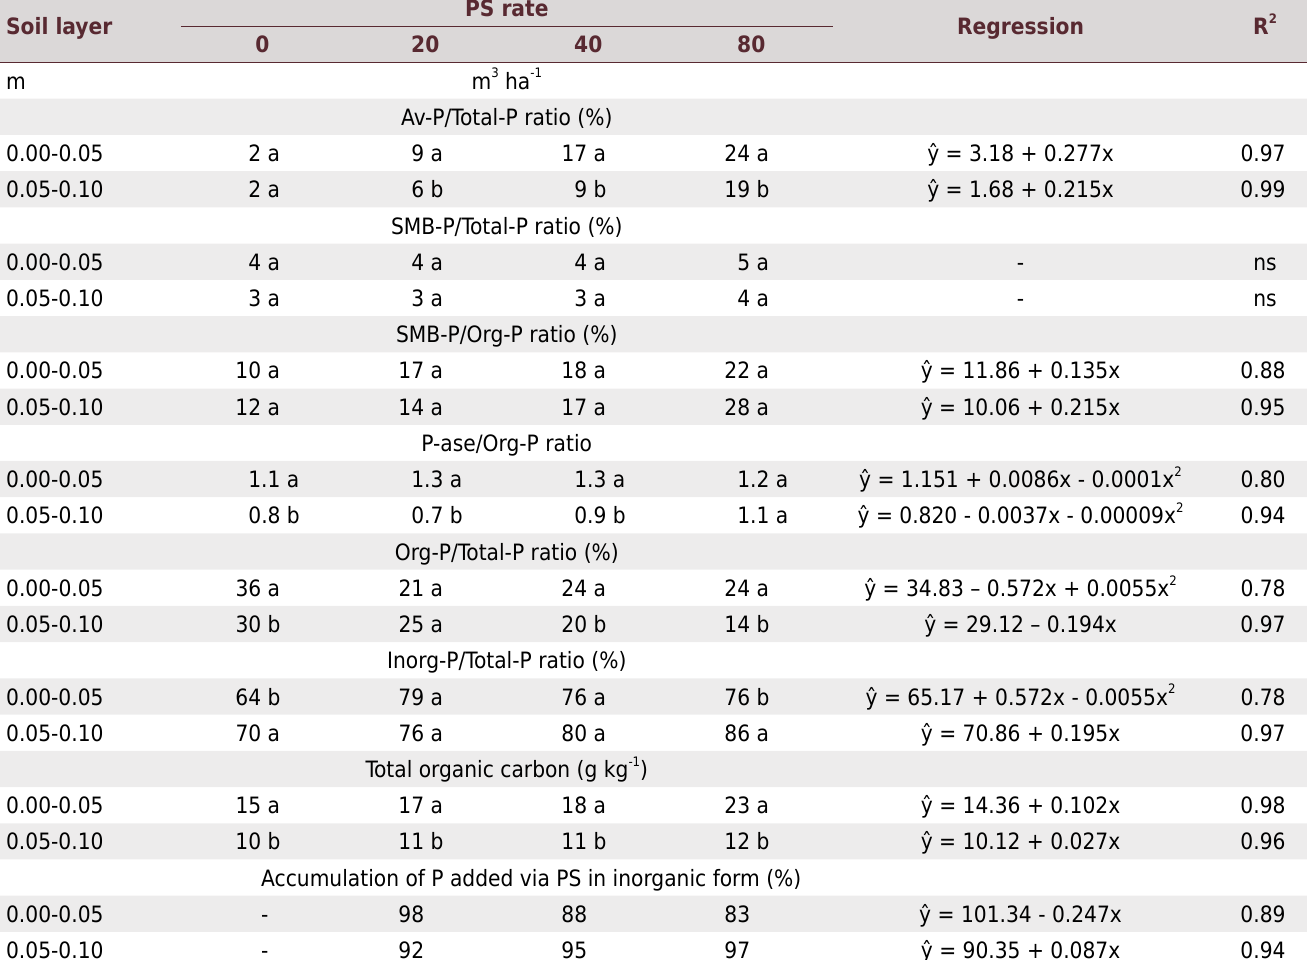
Table 4. Ratios of Av-P/Total-P, SMB-P/Total-P, SMB-P/Org-P, P-ase/Org-P, Org-P/Total-P, Inorg-P/Total-P, total organic carbon, and accumulation of P added via PS in inorganic form in soil treated with 19 PS applications over 8 years, in Santa Maria, Rio Grande do Sul, Southern